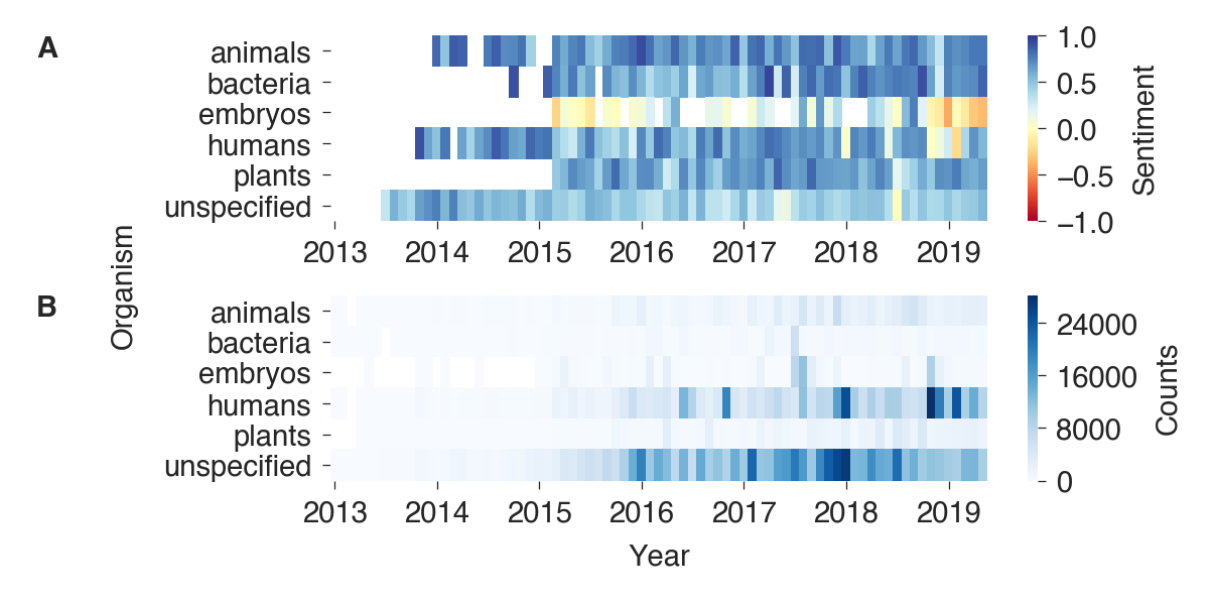
Figure 3. A) Heatmap of monthly sentiments by predicted organism. The sentiments were calculated as the mean of the weighted counts by sentiment (the weights included −1, 0, and 1 for negative, neutral, and positive tweets, respectively) for each month and organism class. Blue and red colors indicate positive and negative sentiment values, respectively. The sentiments of heatmap cells with <100 tweets of that month and organism are transparent. B) Monthly counts by predicted